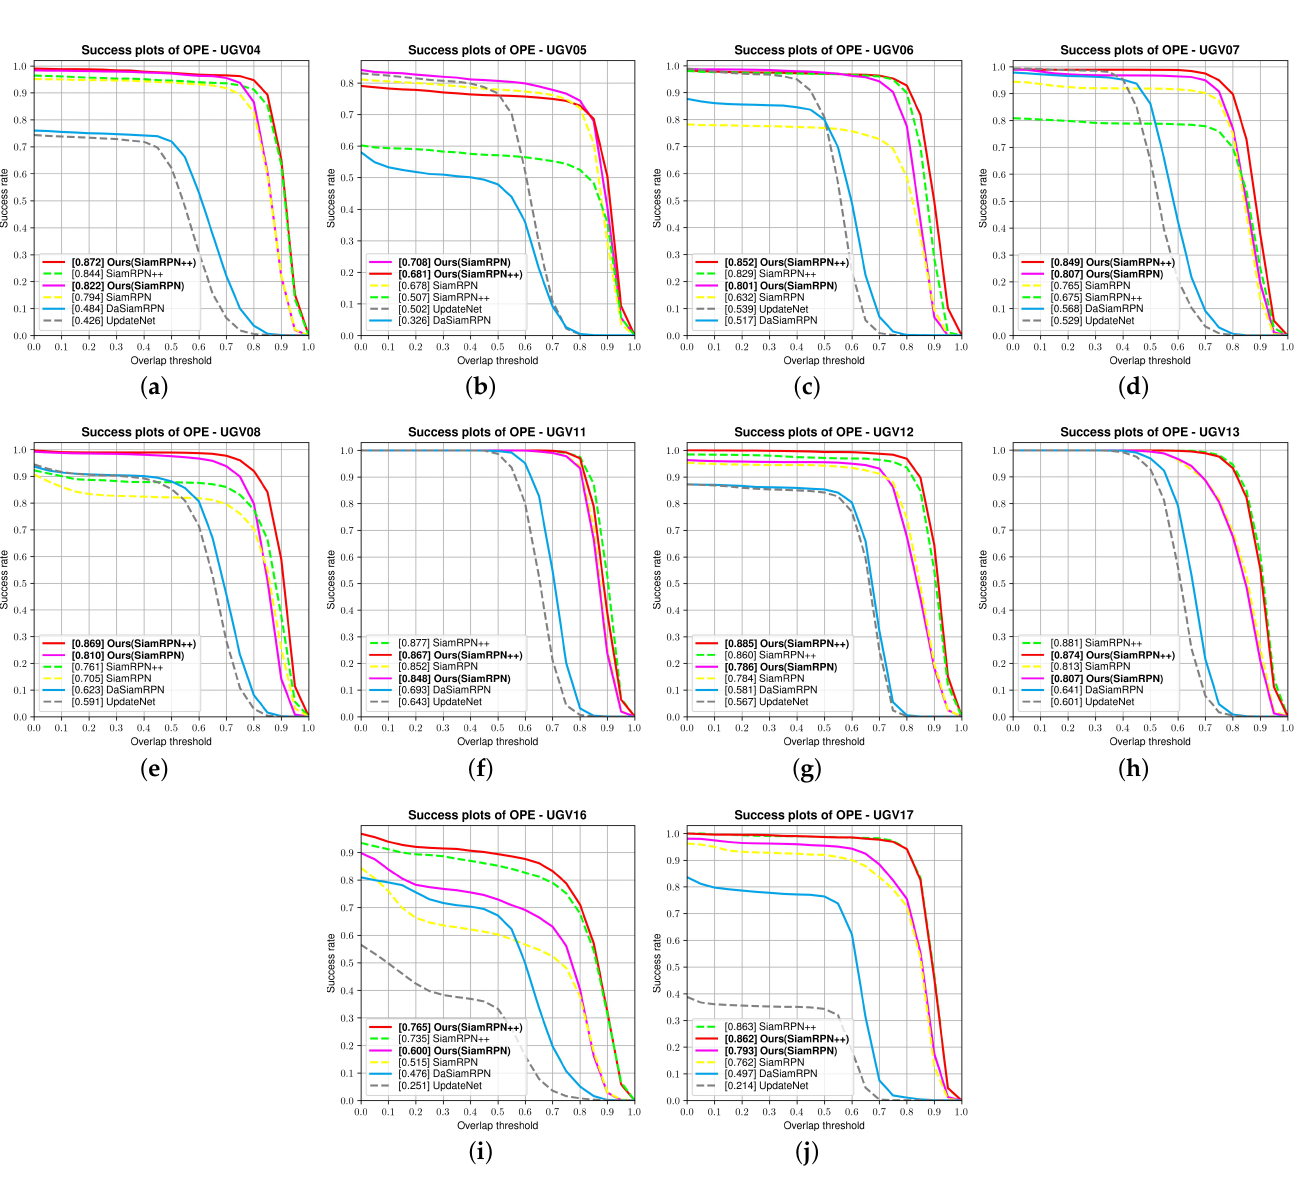
Figure 7. Success plots of long-term